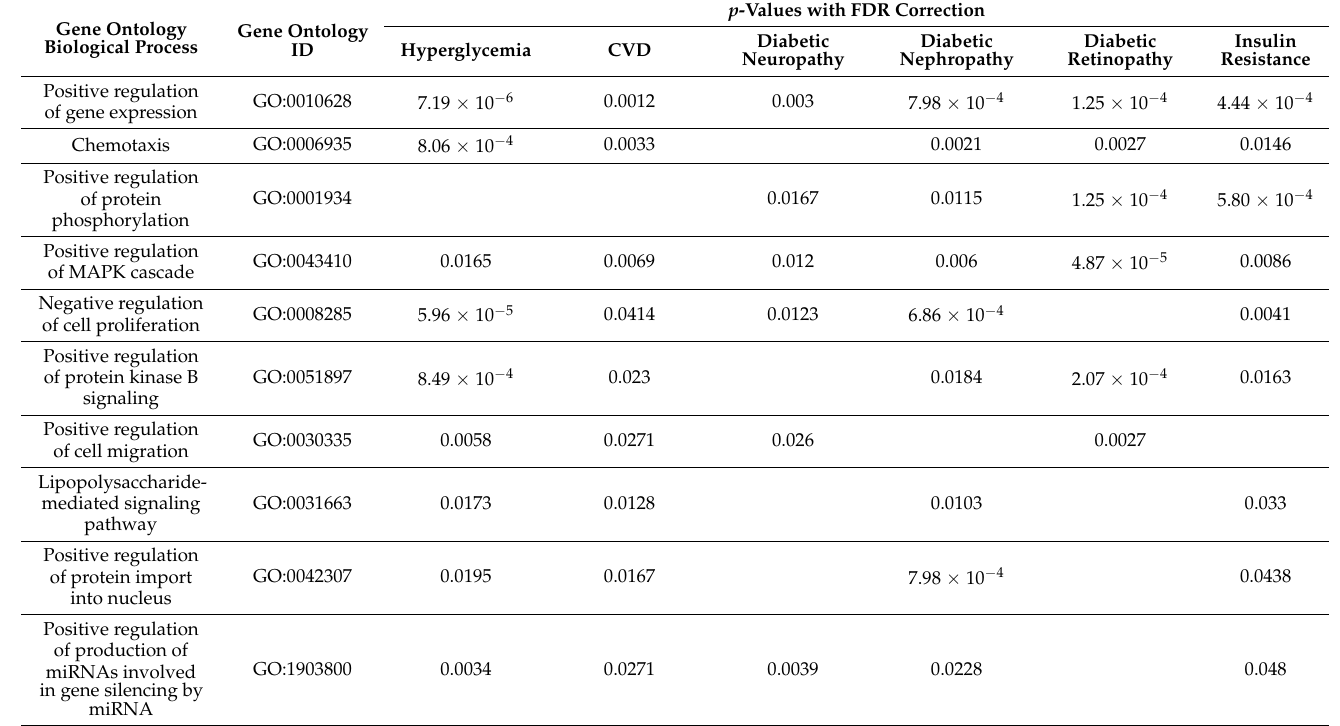
Table 9. Most overrepresented GO biological processes that are common for the sets of genes linked with CTSL and associated with hyperglycemia, CVD, diabetic neuropathy, diabetic nephropathy, diabetic retinopathy, and insulin